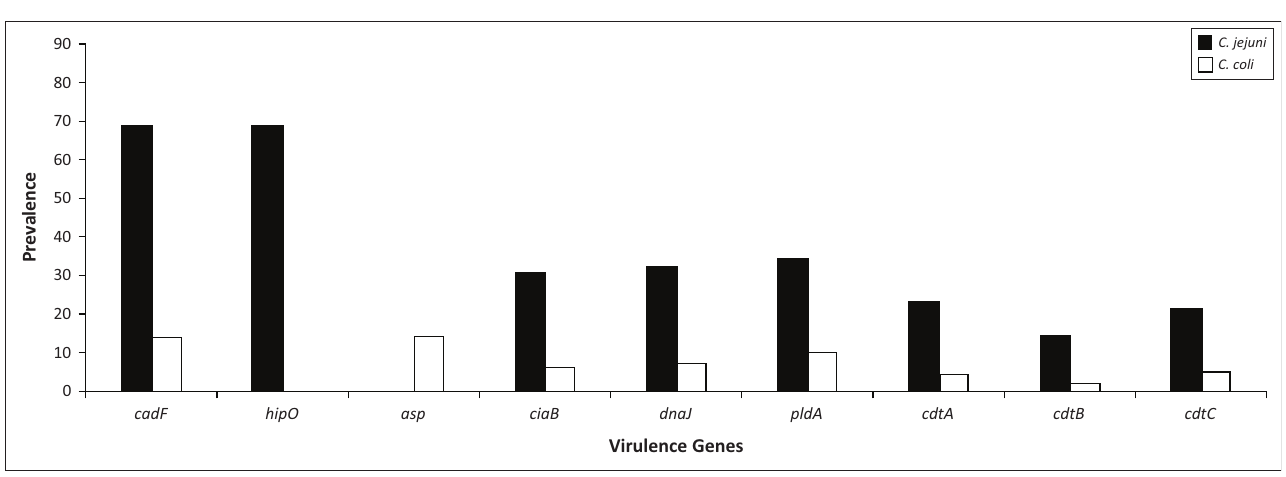
FIGURE 3: Prevalence of virulence genes in Campylobacter jejuni and Campylobacter coli isolated from human clinical isolates.